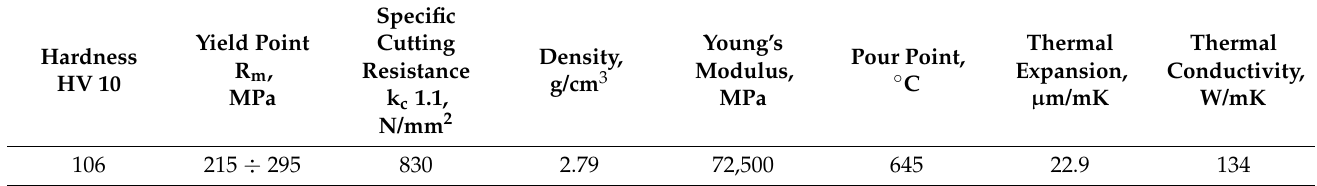
Table 2. Basic mechanical and physical properties of the workpiece